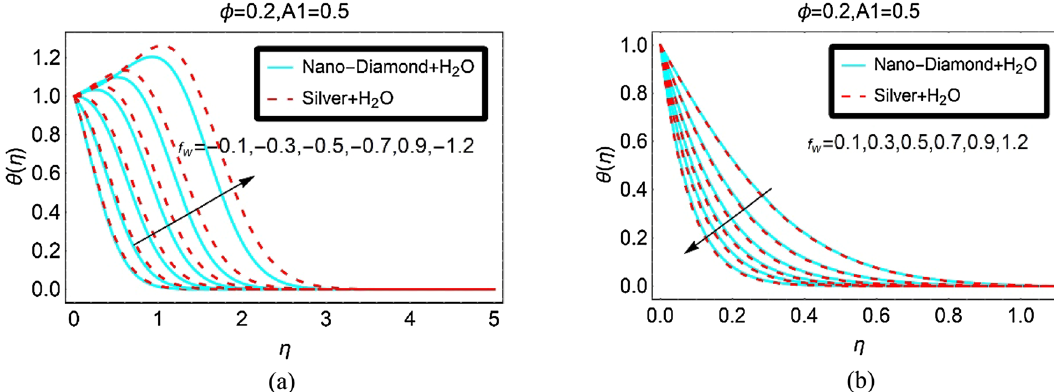
Figure 5. The Temperature against ( a ) Injection and ( b ) Suction.